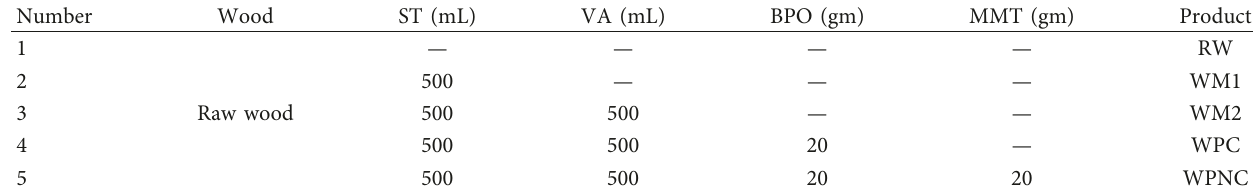
Table 1: Different chemical agents used for preparation of wood polymer composites.